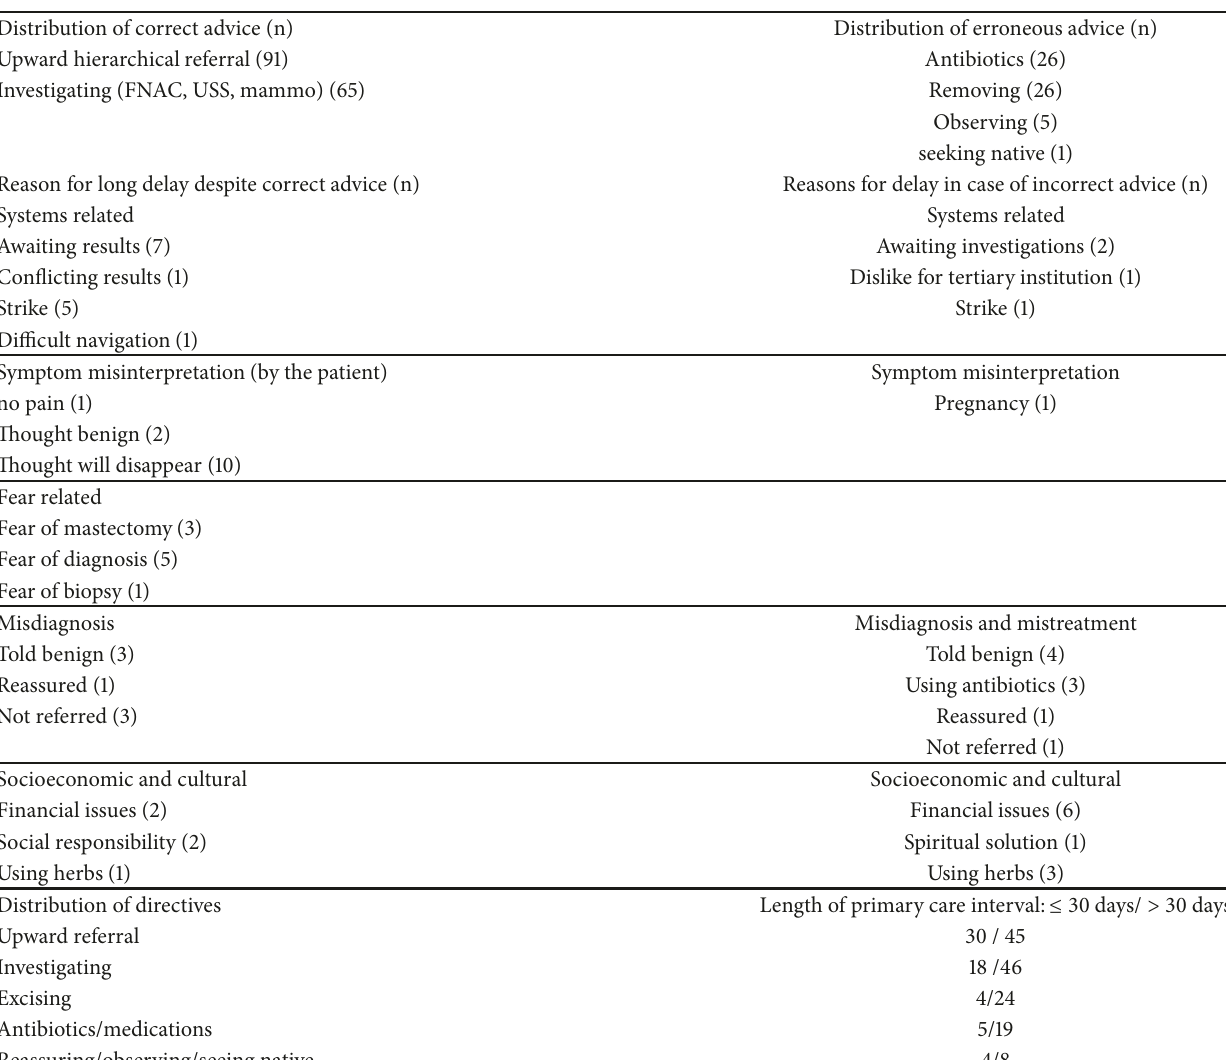
Table 3: Classes of advice and errors of the First Healthcare Provider (FHP): The most frequent erroneous advice was attempts to treat by excision or antibiotics. The common reasons for long interval despite correct advice were systems related and symptom misinterpretation. The most frequent directive from the FHP was an upward referral or to